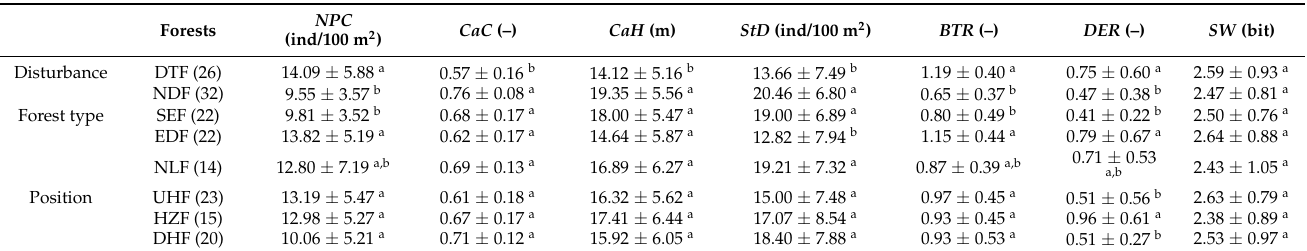
Table 4. Statistics of stand variables on bamboo–woodland interfaces in various disturbances, forest types and positions.